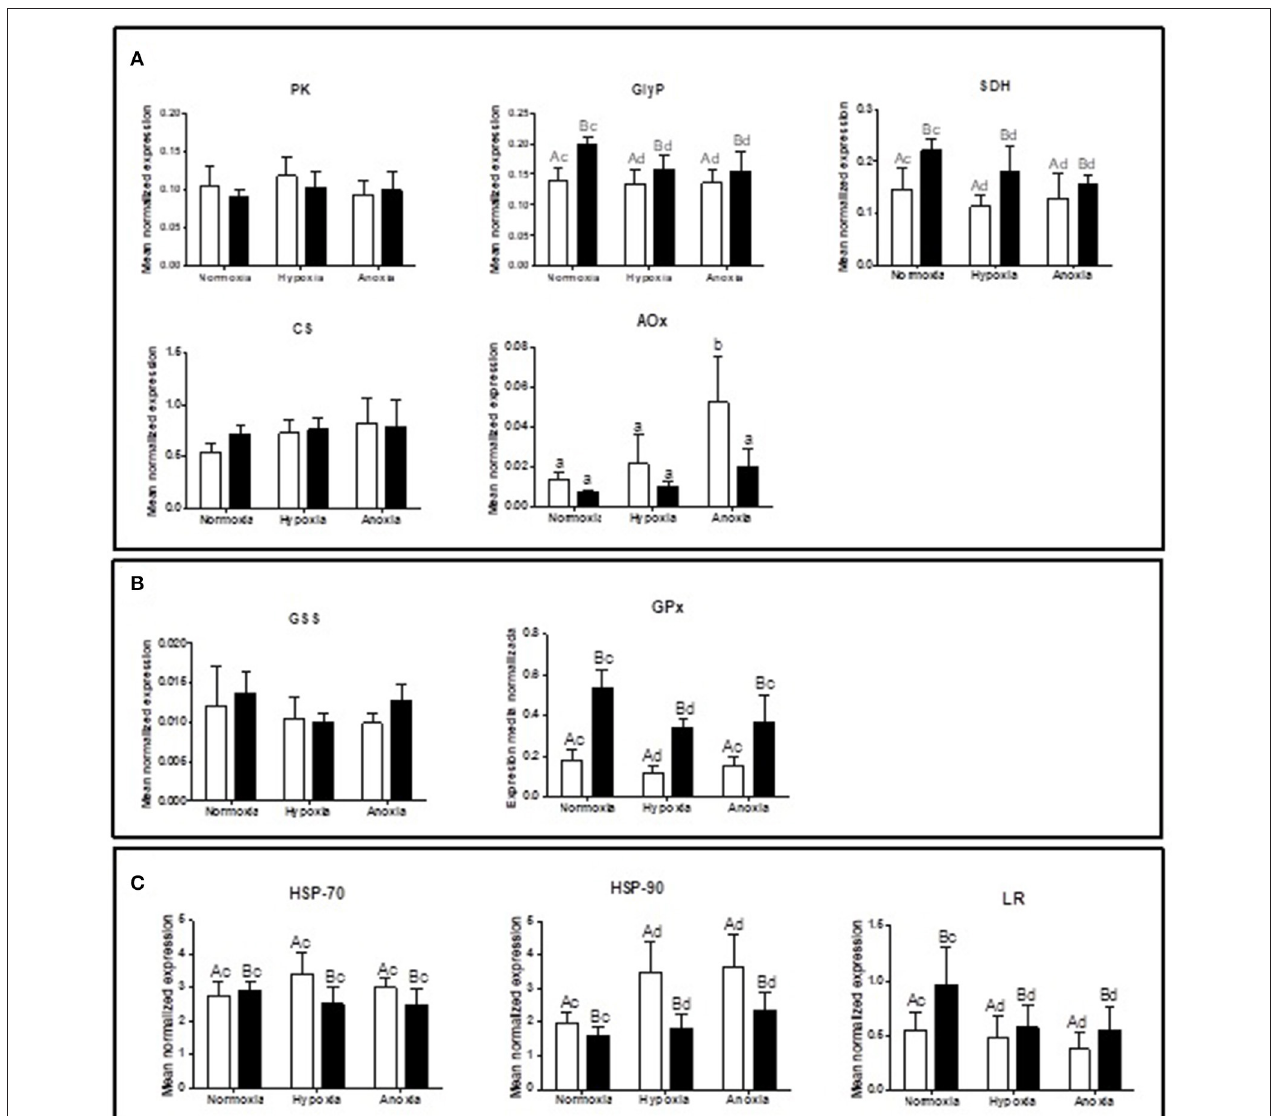
FIGURE 1 | Gene expression levels of (A) PK (pyruvate kinase), GlyP (glycogen phosphorylase), SDH (succinate dehydrogenase), CS (citrate synthetase), and AOX (alternative oxidase); (B) GSS (glutathione synthetase) and GPx (glutathione peroxidase); and (C) HSP-70, HSP-90, and LR (laminin receptor) in gill (white bars) and mantle (black bars) of D. chilensis exposed to anoxia ( < 0.2mg O 2 /L), hypoxia (2mg O 2 /L), and normoxia (9mg O 2 /L, control group), (means ± SD, n = 5, except for normoxia-exposed bivalves in mantle n = 4). Letters a and b indicate significant differences between tissues, c and d among oxygen concentration conditions ( p < 0.05). For AOX different letters indicate significant differences ( p <